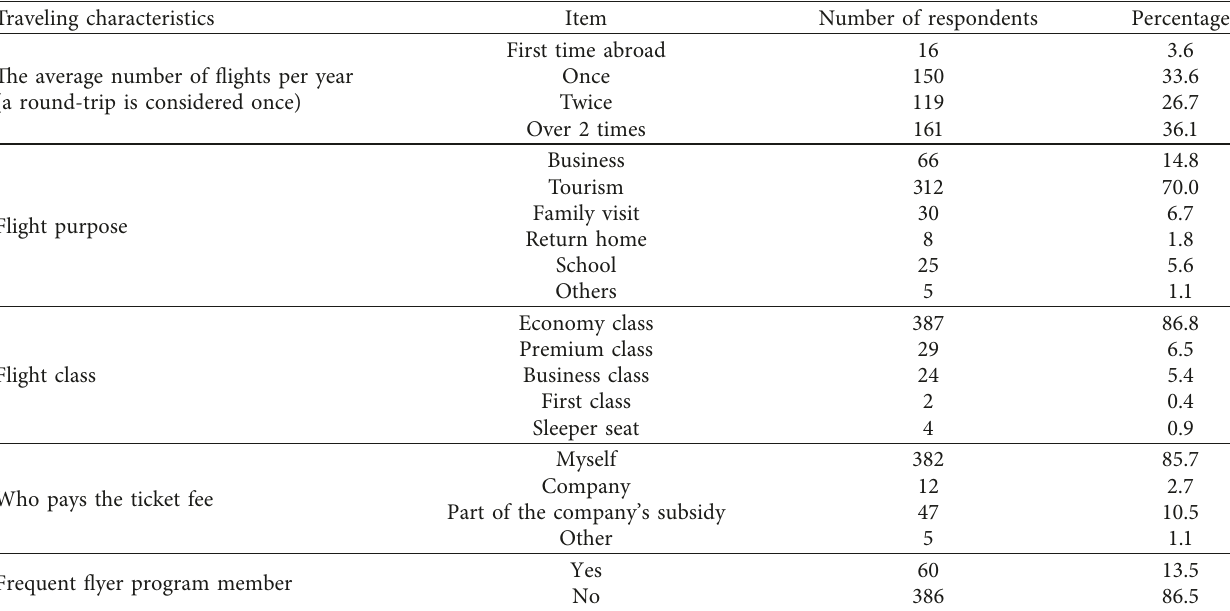
Table 3: Travel frequency characteristics